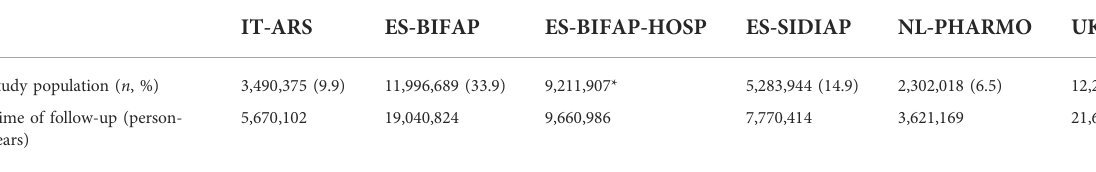
TABLE 2 Baseline characteristics of the study population for the cohort study at 1 January